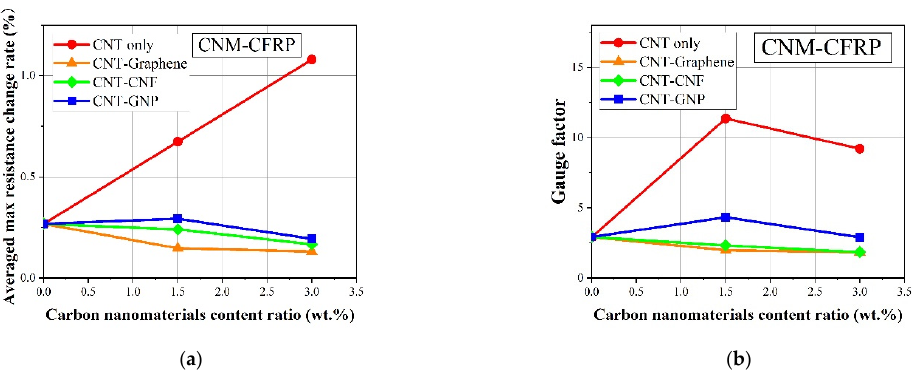
Figure 10. ( a ) Average maximum electrical resistance change rate and ( b ) gauge factor of the CNM-incorporated CFRP composites.